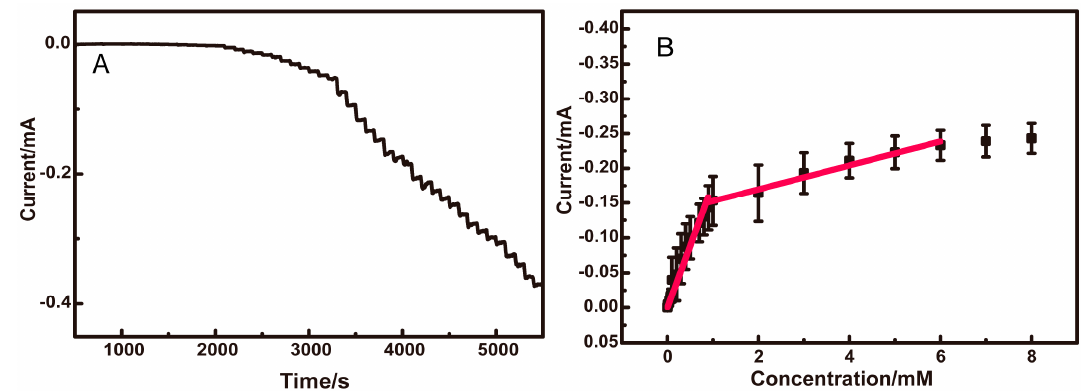
Figure 7. ( A ) i-t curves of CuO/PCL@PPy/ITO response to different concentrations of glucose in 0.01 M NaOH at 0.7 V; ( B ) the corresponding quantitative calibration curves.